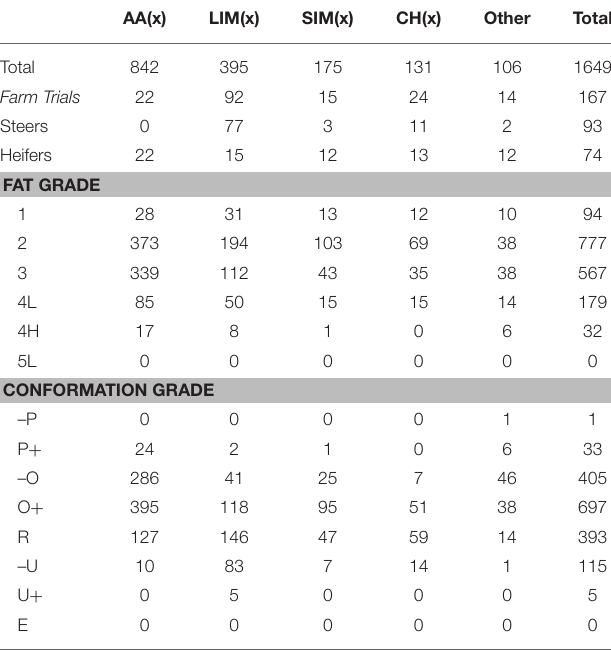
See Table 1 for breakdown of animal breeds and sexes from the abattoir trial. Fat and conformation grades as predicted by VIA. AA, Aberdeen Angus; LIM, Limousin; SIM, Simmental; CH, Charolais.